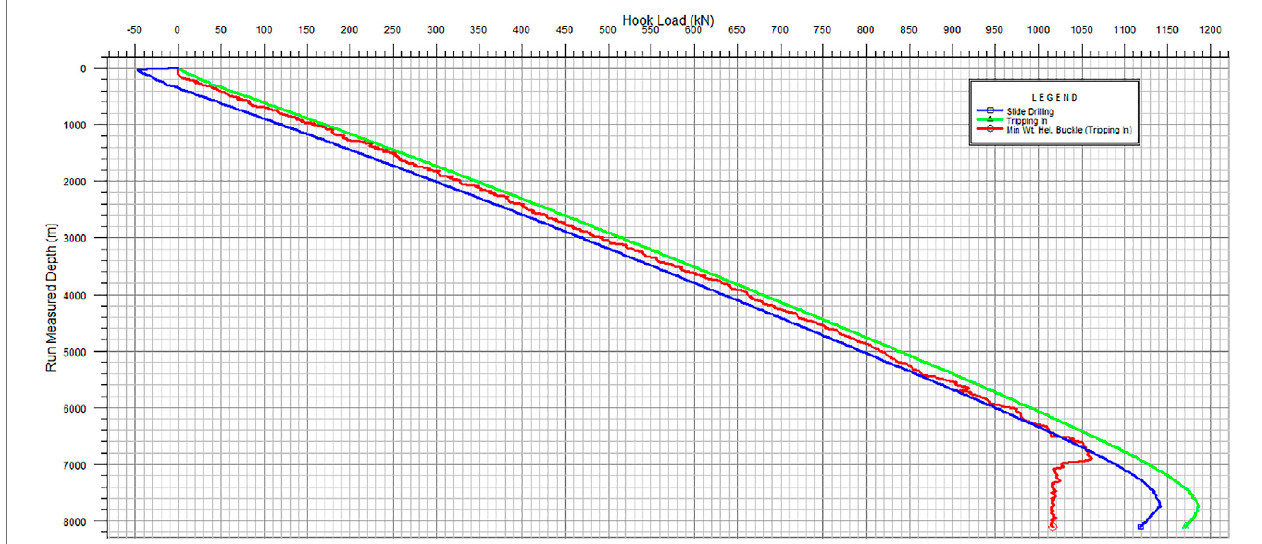
FIGURE 11 | Simulation of running in the open-hole staged fracturing tool for well M.